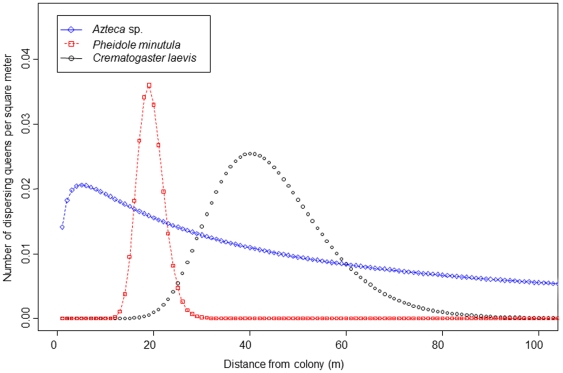
Dispersal kernels for three species of Amazonian plant-ants.Dispersal kernels (i.e., probability density functions describing the spatial redistribution of queens around reproductive colonies) for ant queens obligately nesting in Tococa bullifera or Maieta guianensis. These kernels are scaled for a colony housed in a plant of the median size observed in our 9-ha study plot.